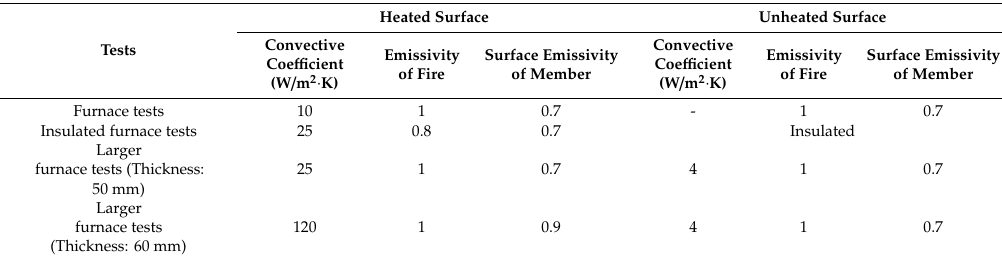
Table 2. Boundary conditions of furnace tests in FEA.